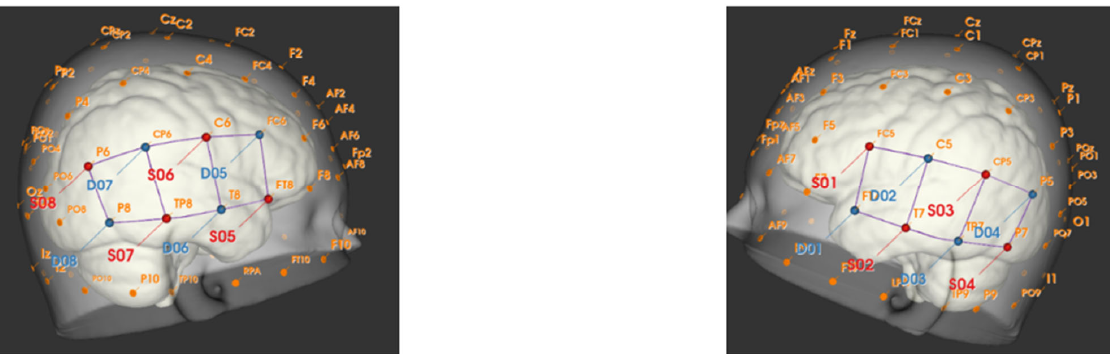
Figure 1. Optode positions and the corresponding cortical landmarks below the scalp; 10 channels (“source-detector” pairs) are available in the left hemisphere and 8 channels in the right hemisphere, the most posterior detector (D08) being used for short channels.